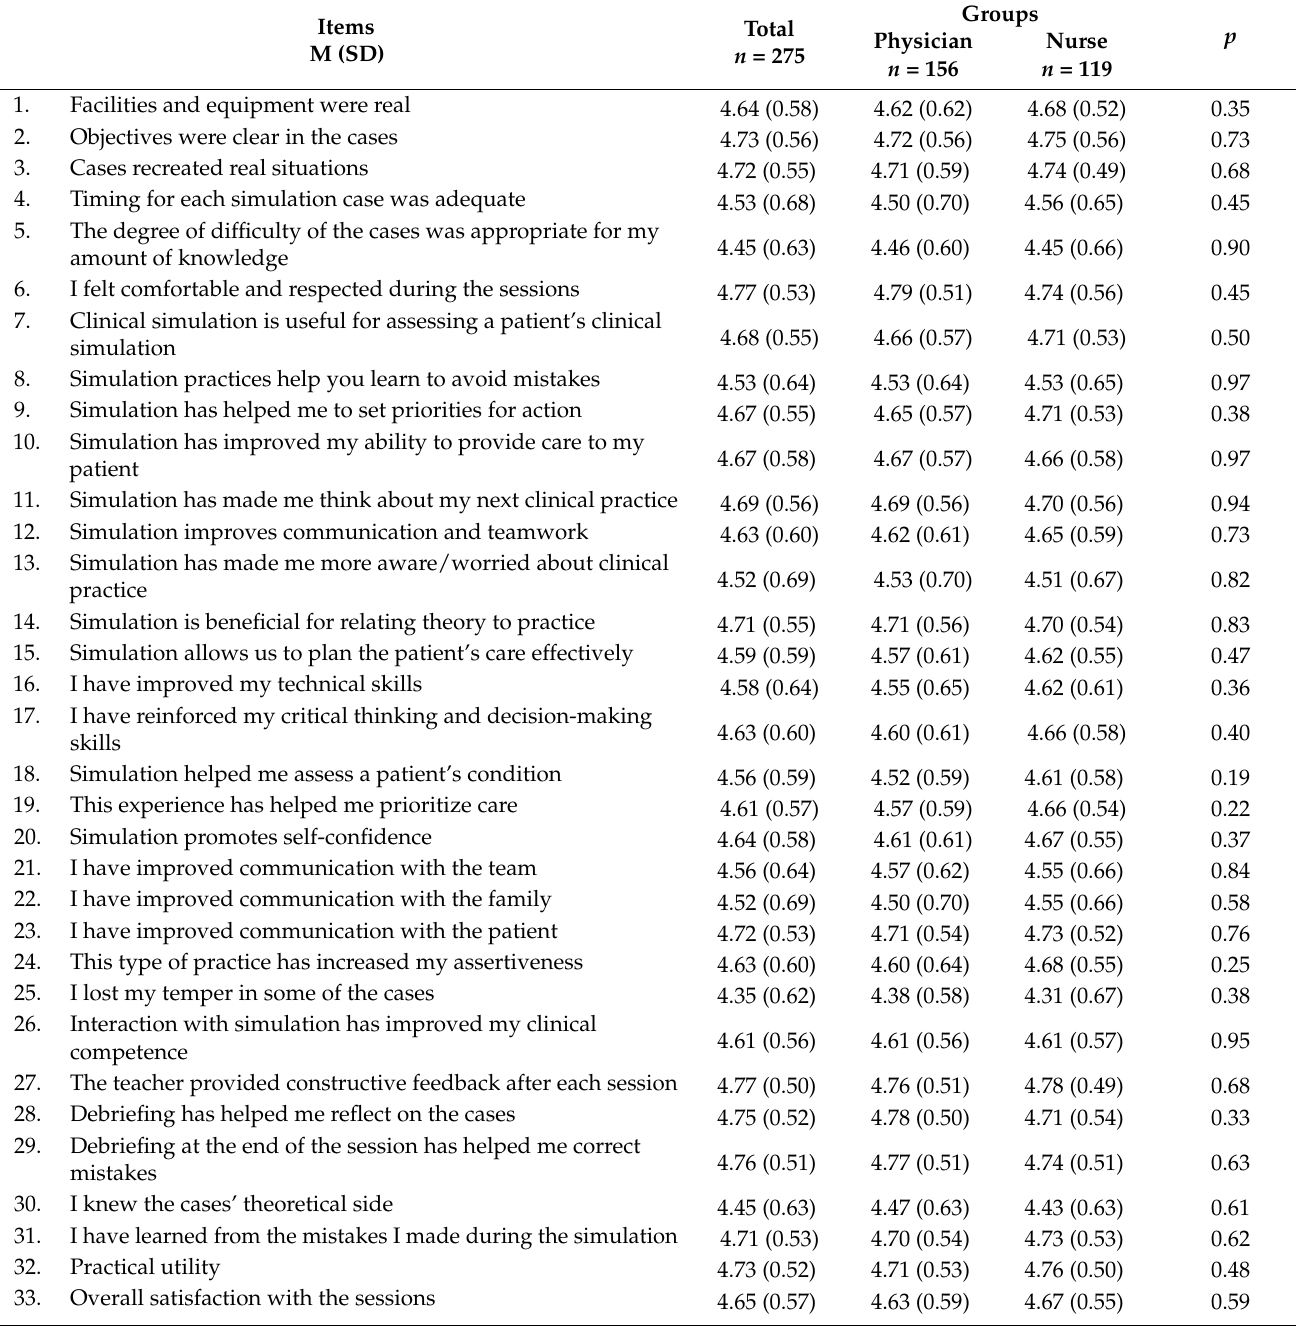
Table 5. Descriptive analysis for items of the clinical simulation satisfaction